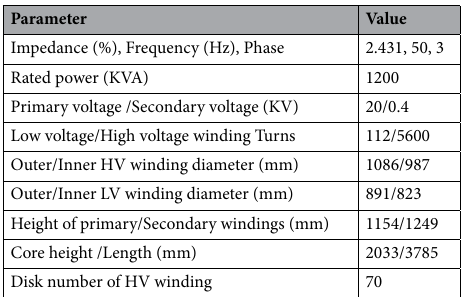
Table 4. Specifications of the transformer under study.